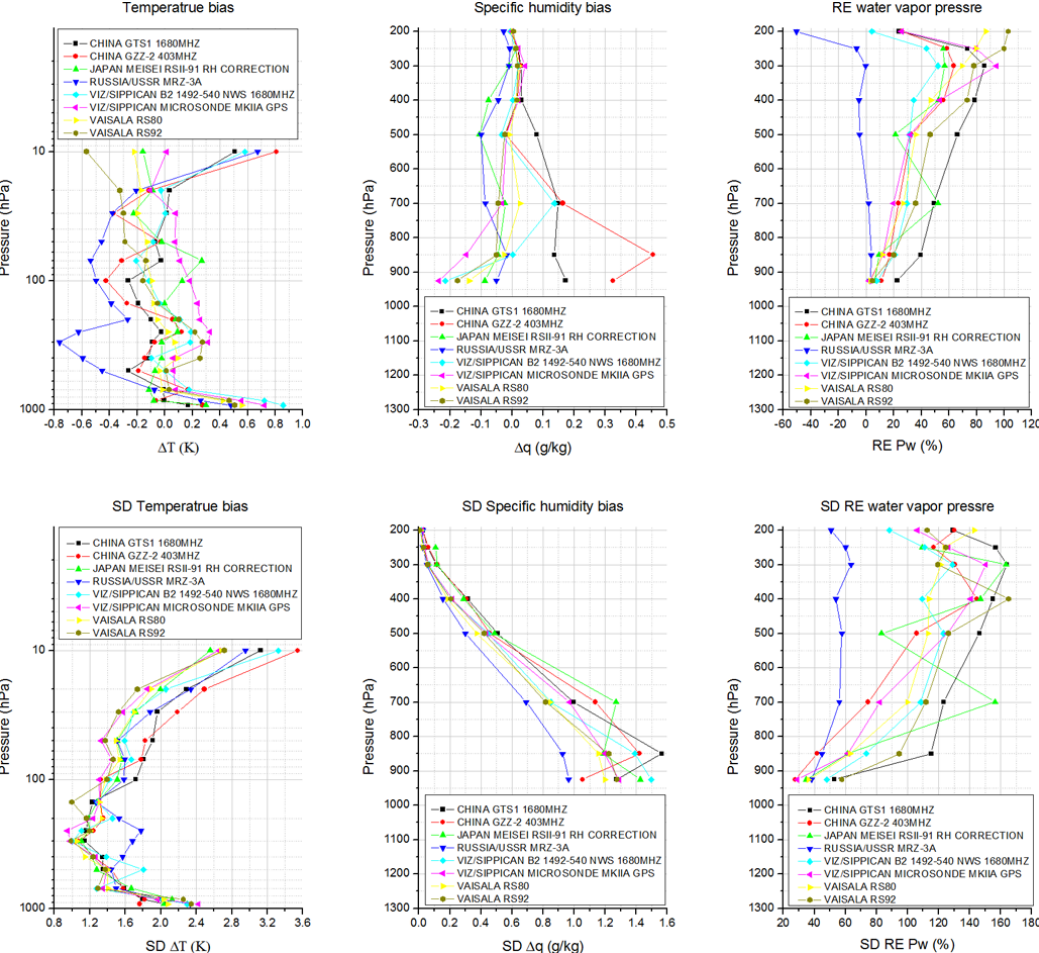
Fig. 9. Differences in mean temperature bias, mean specific humidity bias, relative error of water vapor pressure and their SDs between COSMIC and different radiosonde types. Radiosonde data is the